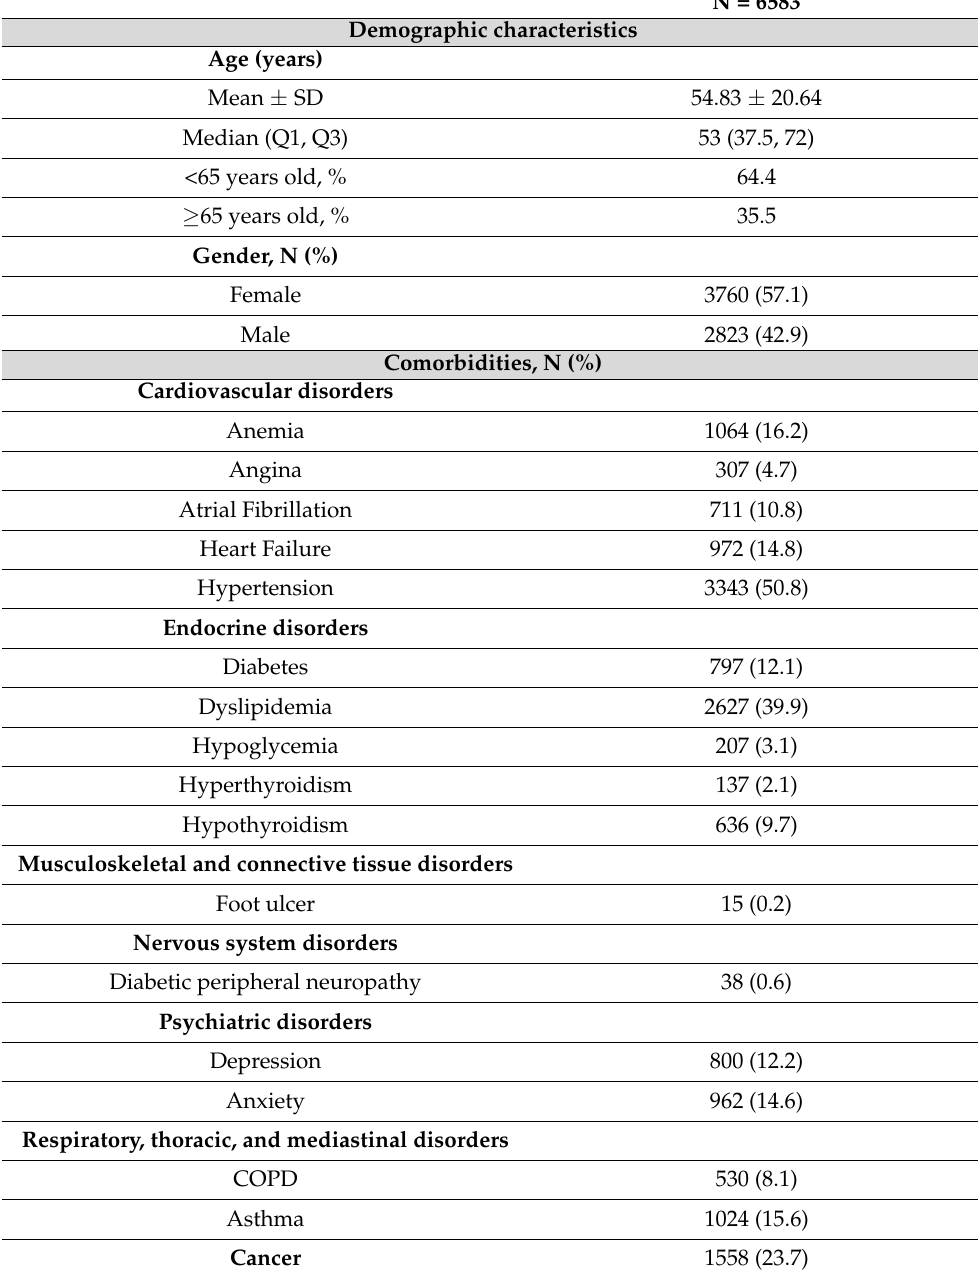
Table 1. Demographic data and clinical characteristics of patients with acute bacterial conjunctivitis diagnosed on a clinical